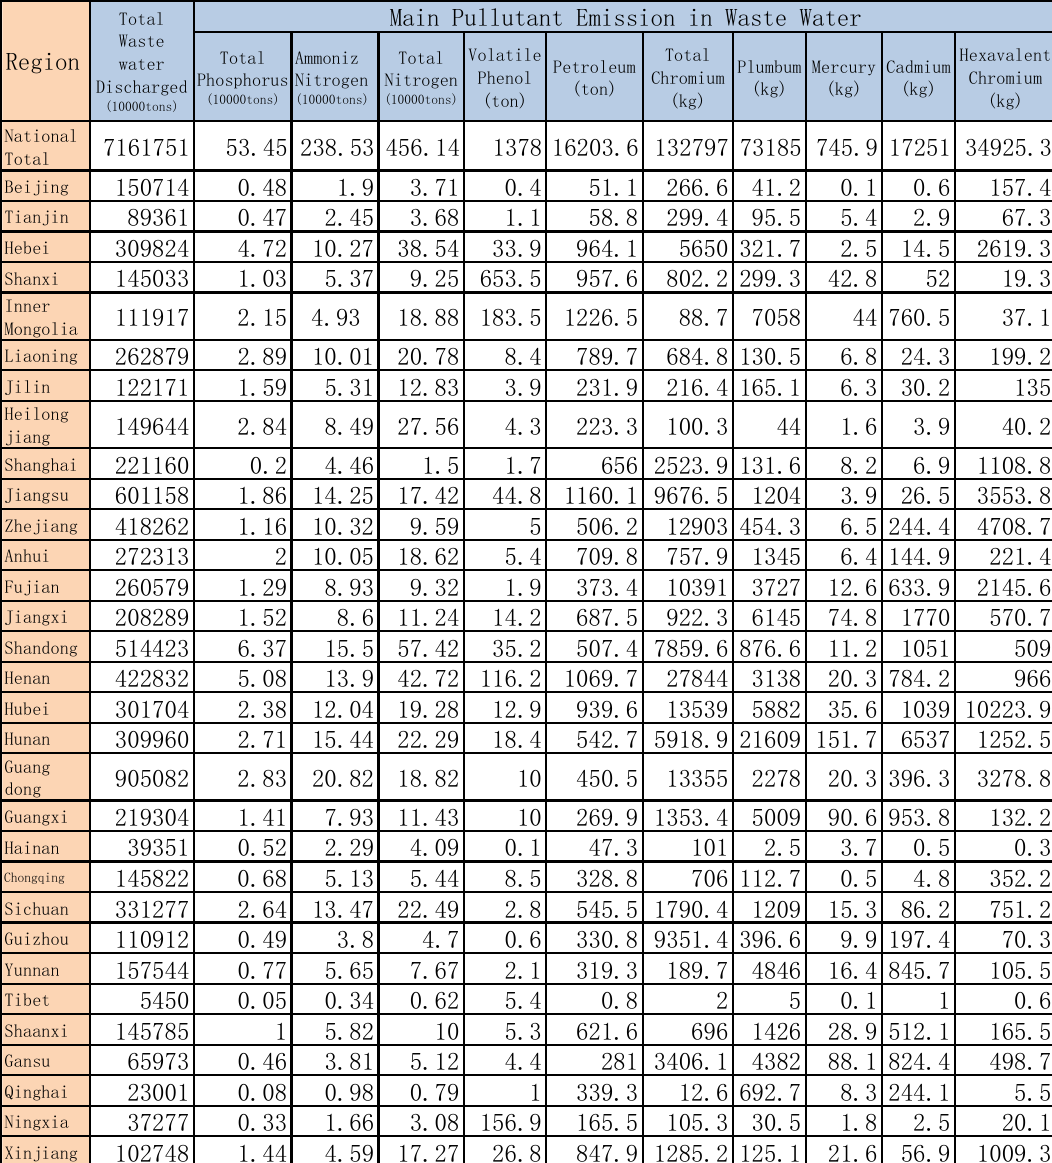
Figure A1. The main pollutant emissions in waste water by region in China in